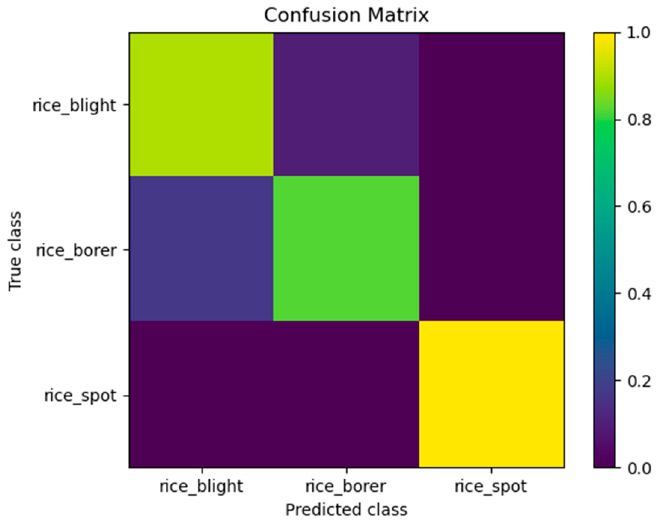
Figure 7. Confusion matrix of Video 1 which contains rice sheath blight, rice stem borer symptoms and rice brown spot. Video 1 was captured in Hunan Province, China, July 2018, which was illustrated in the caption of Figure 6. The input data of the confusion matrix was counted manually from Video 1.